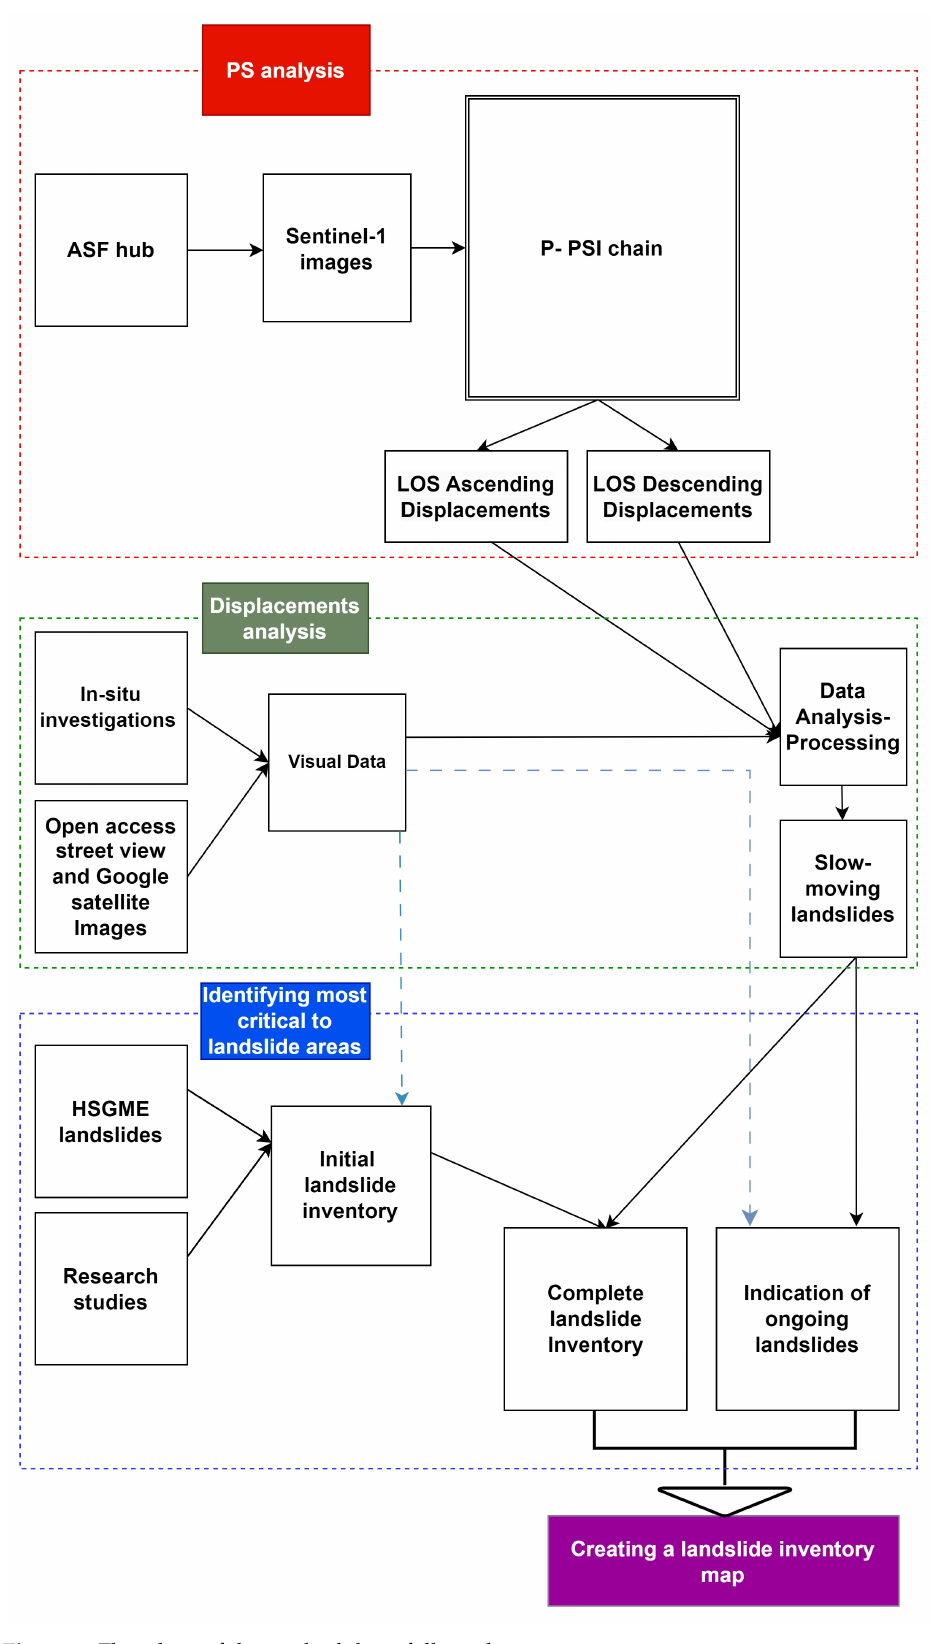
Figure 2. Flowchart of the methodology